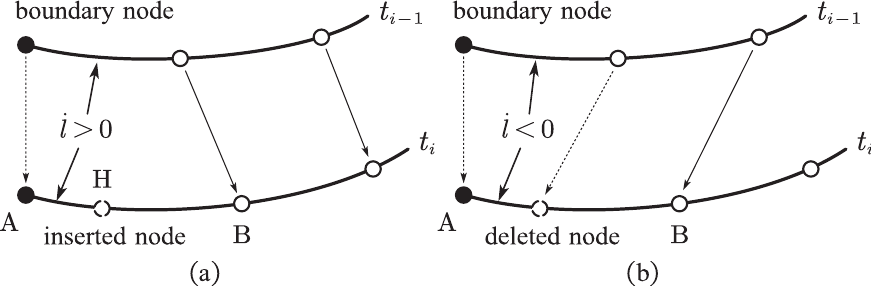
Figure 3. Illustrations of ( a ) element segmentation and ( b ) element merging